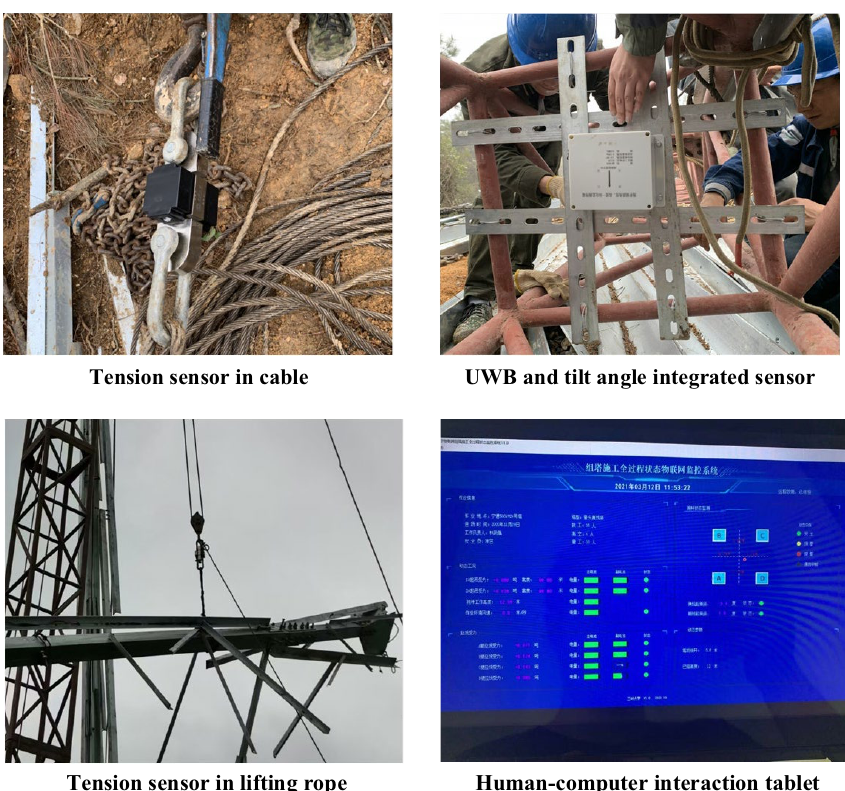
Figure 5. The layout of the monitoring system on the project